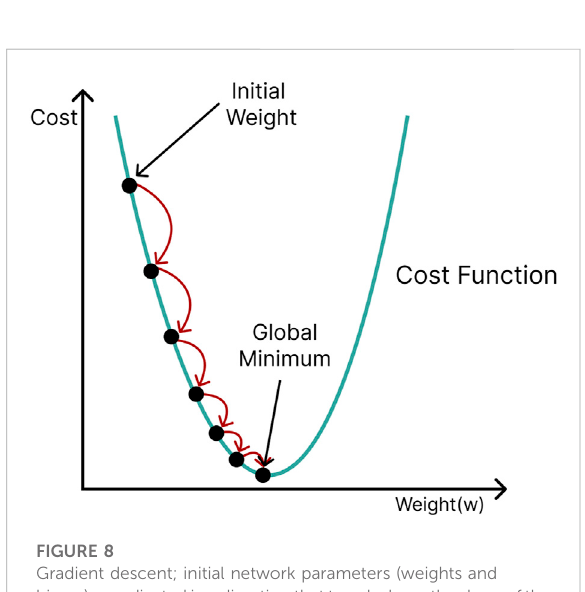
FIGURE 8 Gradient descent; initial network parameters (weights